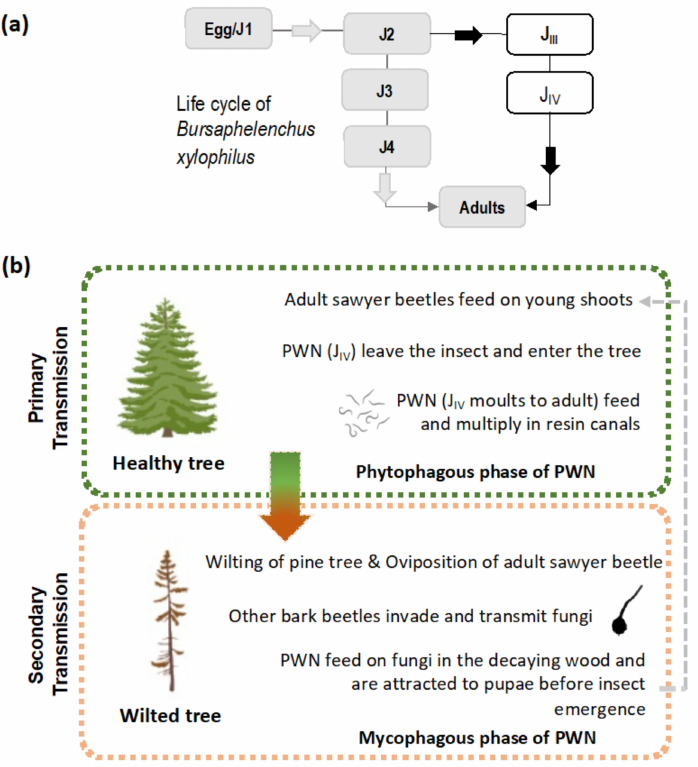
Figure 1. Pine Wilt Disease pathosystem. ( a ) Life cycle of the pinewood nematode Bursaphelenchus xylophilus (grey arrows indicate propagative stage; black arrows indicate dispersal stage); ( b ) Primary and secondary transmission of B. xylophilus by the sawyer beetle Monochamus sp. (grey arrow indicates interconnection between transmission modes). Image of a healthy and wilted tree, retrieved from Biorender ® .